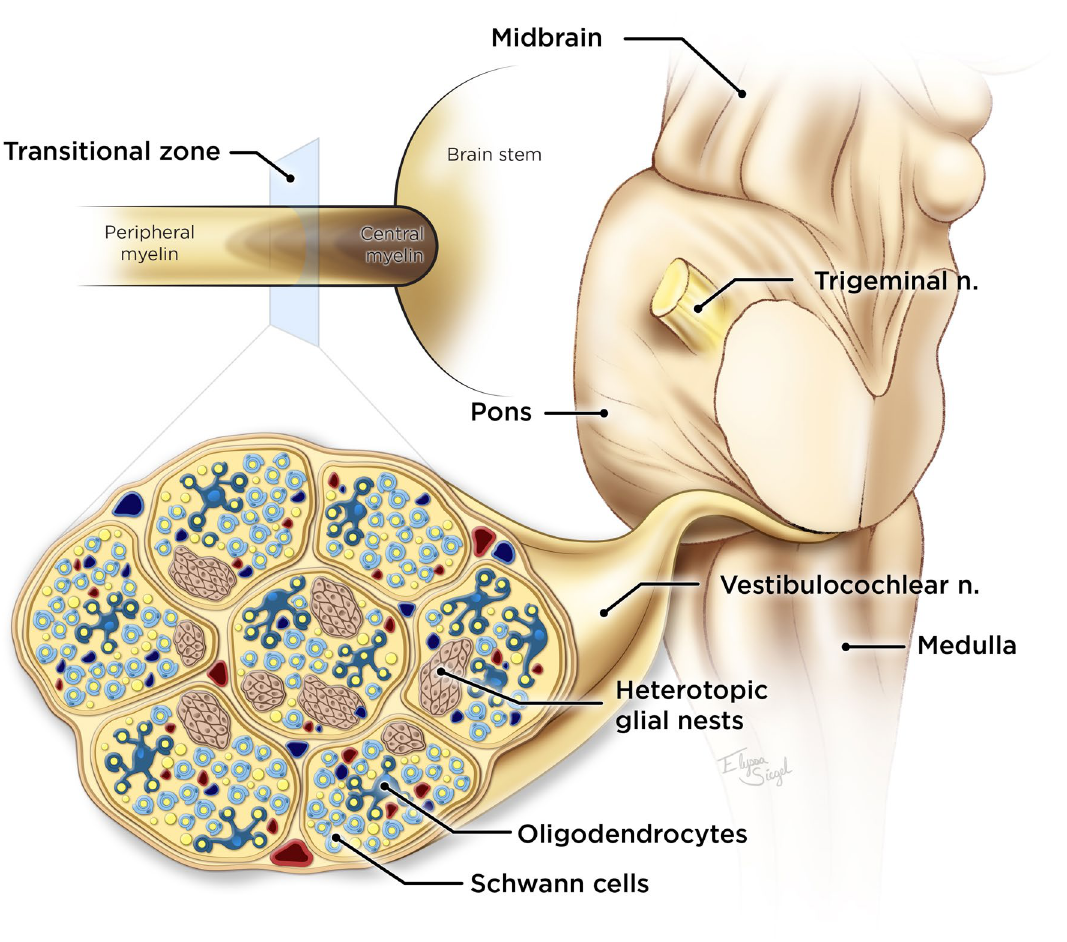
Figure 6. A cross-section of the funnel-shaped transitional zone within the nerve REZ depicts distinct islands of neuroglial tissue, likely the origin of nerve REZ gliomas. In the transitional zone, both Schwann cells and oligodendrocytes are present ©Elyssa Siegel